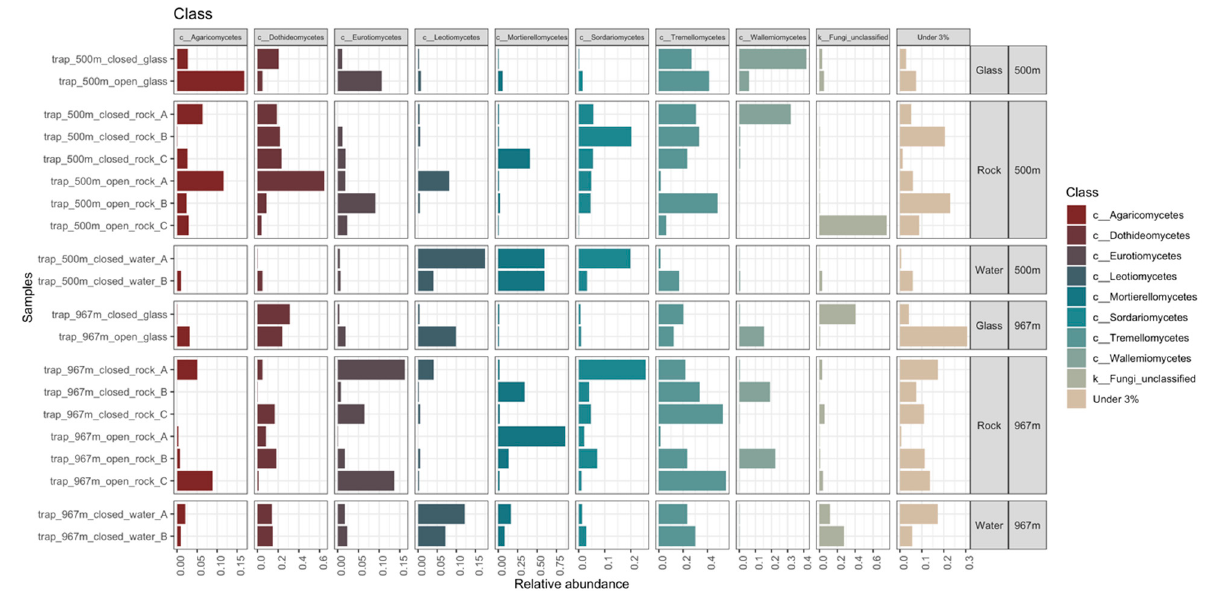
Figure 6. The fungal communities at the different sampling depths (500 or 967 m) and on different surfaces (glass, rock, water) presented on class level. Notice that in this figure, there is a class-wise relative abundance level on x-axis, compare samples within class, not across classes. Classes present at less than 3% relative abundance were merged as group “Under 3%”. In the legend on the right, c in front of the taxon name indicates identification to class level, k indicates identification to kingdom level.